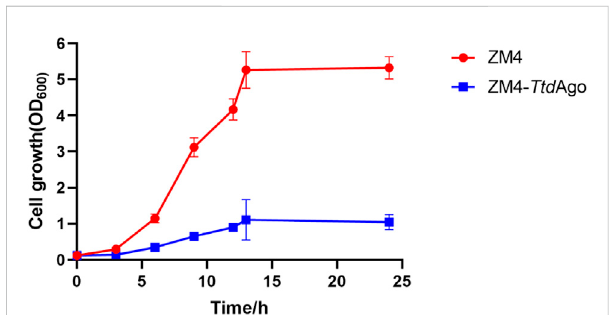
FIGURE 7 Effect of TtdAgo on cell growth of Zymomonas mobilis . Zymomonas mobilis wild-type (ZM4) strains with Ttd Ago expression (ZM4- Ttd Ago) were cultured at 30 ° C. The error bars indicate standard deviations based on three